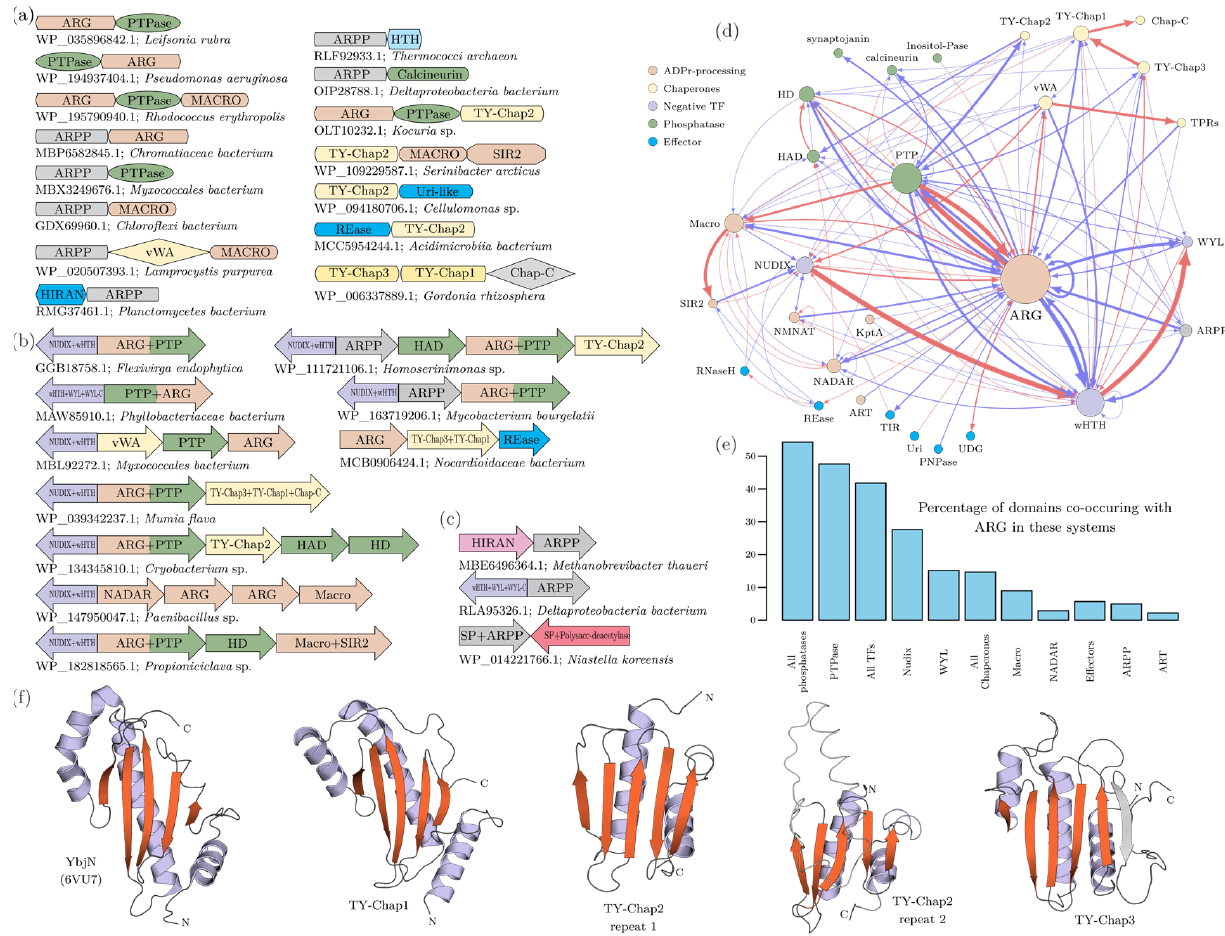
Figure 7. Contextual associations including ( a ) domain architectures and ( b ) gene neighborhoods of the ARG ‐ associated systems. ( c ) More gene neighborhoods of the ARPP domain. ( d ) Contextual network diagram and ( e ) co ‐ occurrence frequencies of domains associated with the ARG domain.